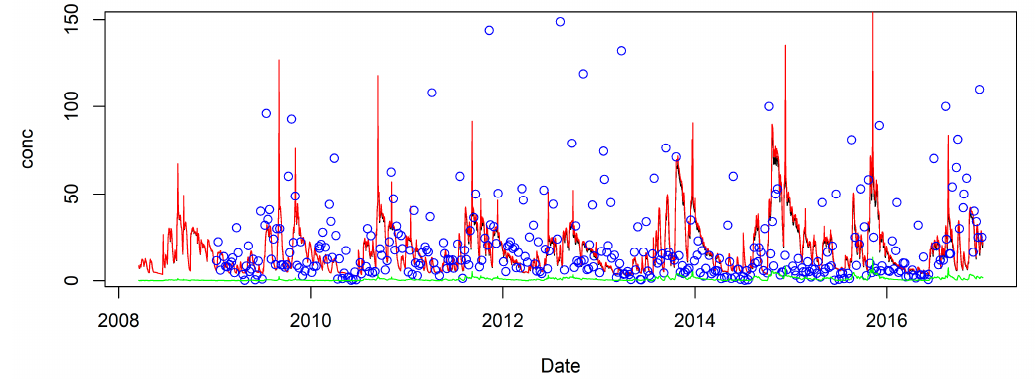
Figure 9. Time series plot of baseline (red), post-intervention (black) and differences (green) in prediction of faecal indicator organisms (FIOs) (counts per billion) from 2000 to 2016. Maximum diffuse concentration improvement was 13.28 ug/L.